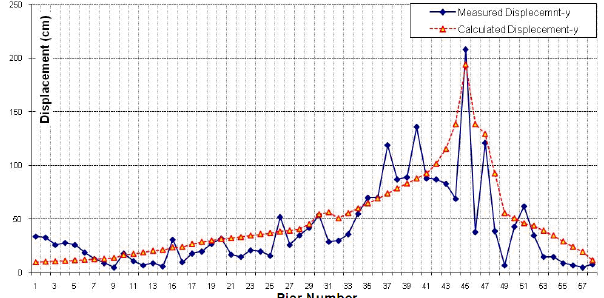
Figure 13. Comparison of the measured and calculated peak displacements of the viaduct Fig. 13. Comparison of the measured and calculated peak piers in the y direction caused by the Düzce earthquake displacements of the viaduct piers in the y-direction caused by the D¨uzce